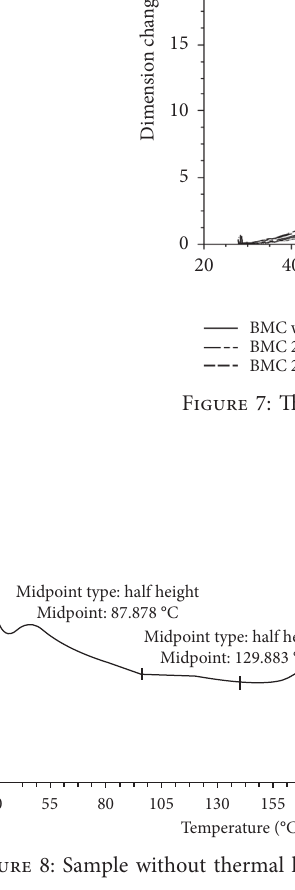
Figure 9: Sample after load 200 ° C/30 minutes:1 st heating (1 st step); 2 nd heating (2 nd step).